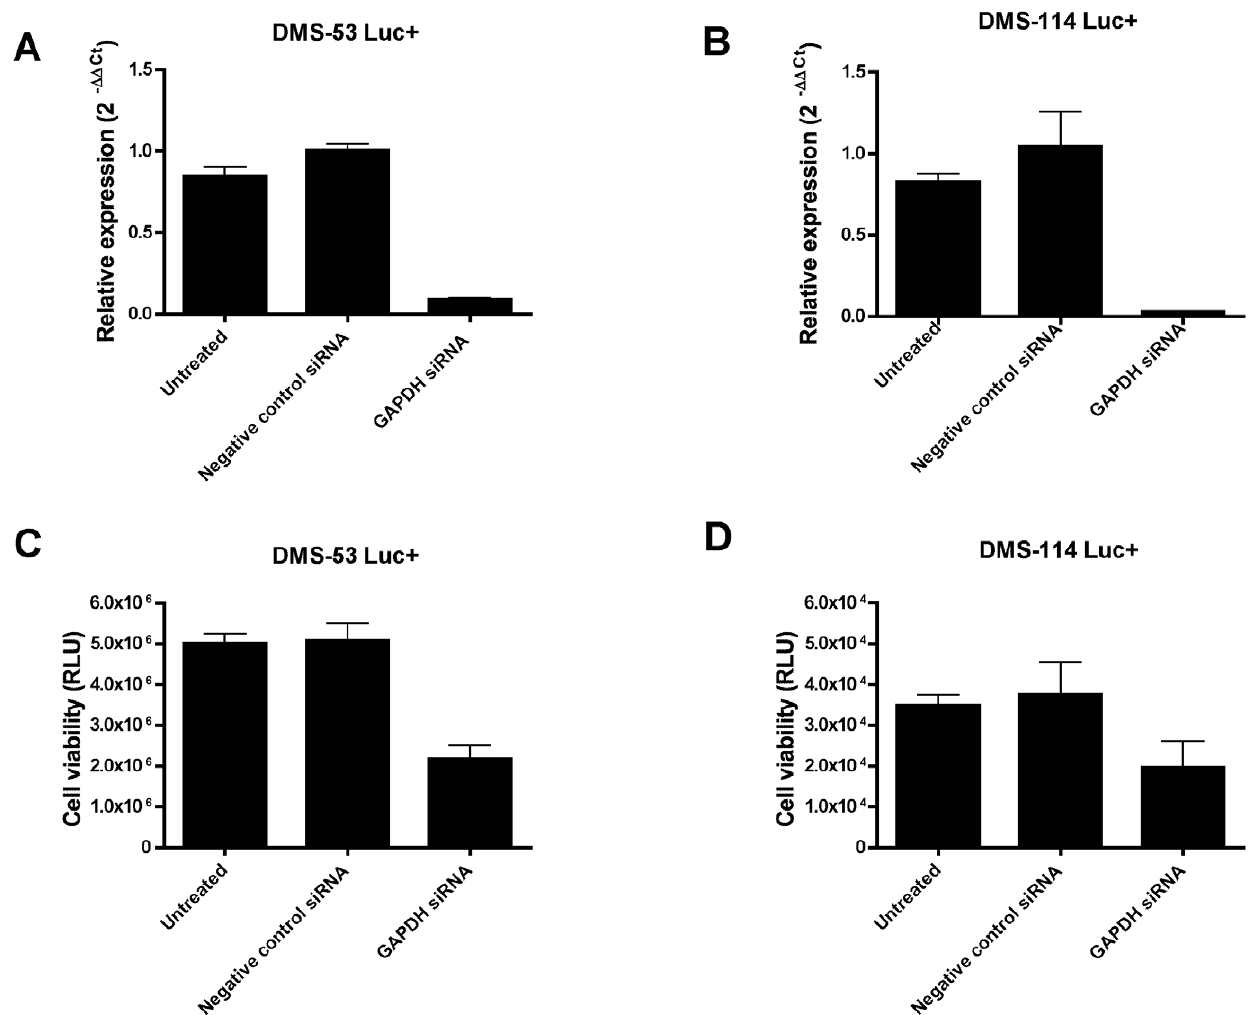
Figure 3. Bioluminescent SCLC cell lines respond to GAPDH depletion. DMS-53 luc + and DMS-114 luc + cells were treated with siRNAs against the housekeeping gene, GAPDH. GAPDH levels after knockdown were measured using quantitative RT-PCR. Approximately 91% and 97% knockdown was achieved for DMS-53 luc + and DMS-114 luc + cells, respectively ( A, B ). Negative controls included untreated cells (‘‘Untreated’’) and cells treated with a negative control siRNA provided by the manufacturer (‘‘Negative Control siRNA’’, Applied Biosystems). Cell viability upon GAPDH silencing was measured using luciferase assays ( C,D ). Points represent mean values and error bars represent standard error of means (n=3 for quantitative RT-PCR, n=4 for luciferase assays).